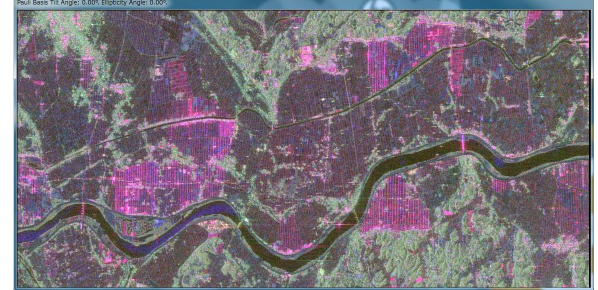
Figure 8. Pauli basis (R: HH-VV G: HV B:HH+VV)